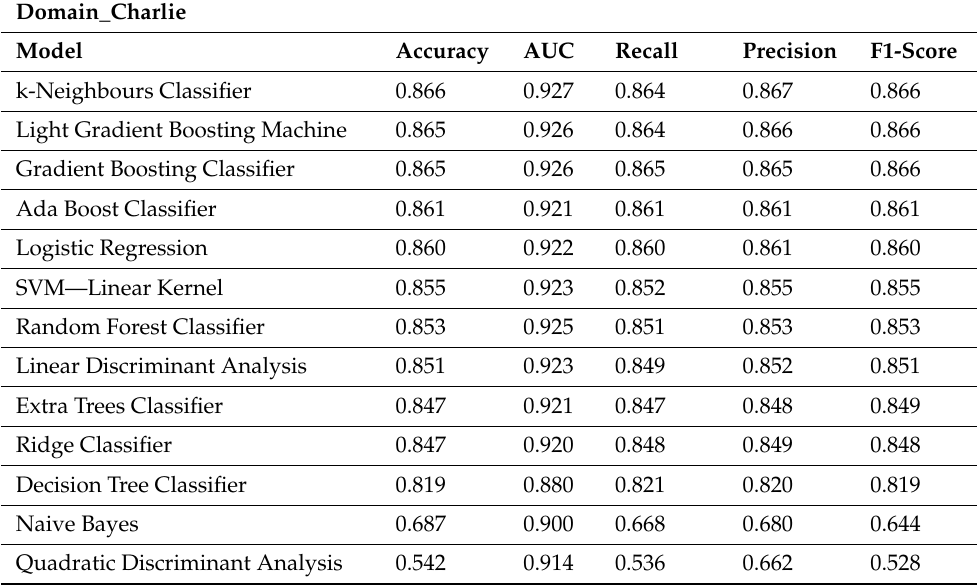
Table 5. The best model for the Domain Charlie.